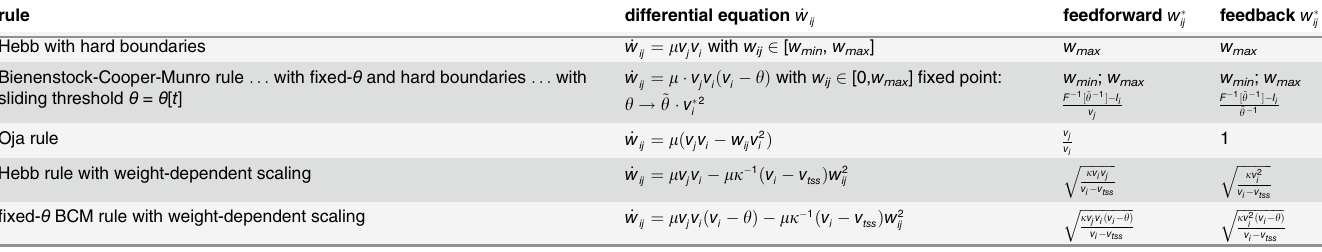
ffiffiffiffiffiffiffiffiffiffi q ffiffiffiffiffiffiffiffiffiffi q k v i v j k v 2 i v i (cid:4) v tss v i (cid:4) v tss ffiffiffiffiffiffiffiffiffiffiffiffiffiffiffi q ffiffiffiffiffiffiffiffiffiffiffiffiffi q k v j v i ð v i (cid:4) y Þ k v 2 i ð v i (cid:4) y Þ v i (cid:4) v tss v i (cid:4) v tss